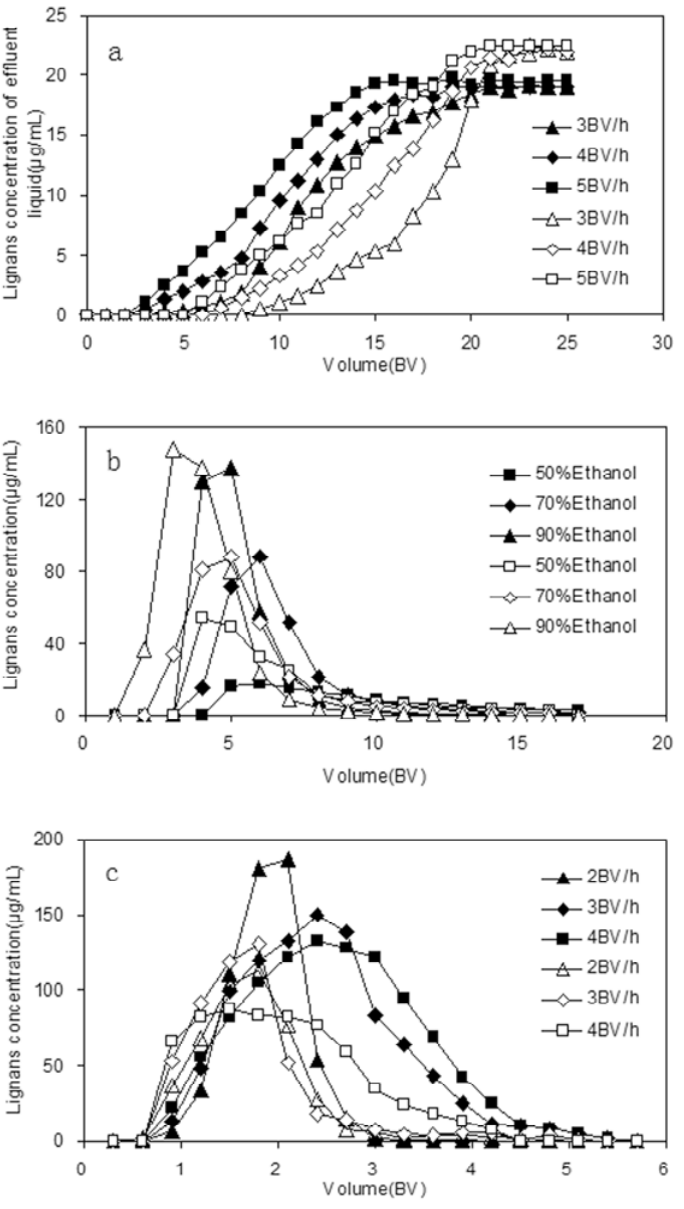
Figure 4. Dynamic leakage curves with different flow rates ( a ), dynamic desorption curves with different ethanol concentrations ( b ) and dynamic desorption curves with different flow rates ( c